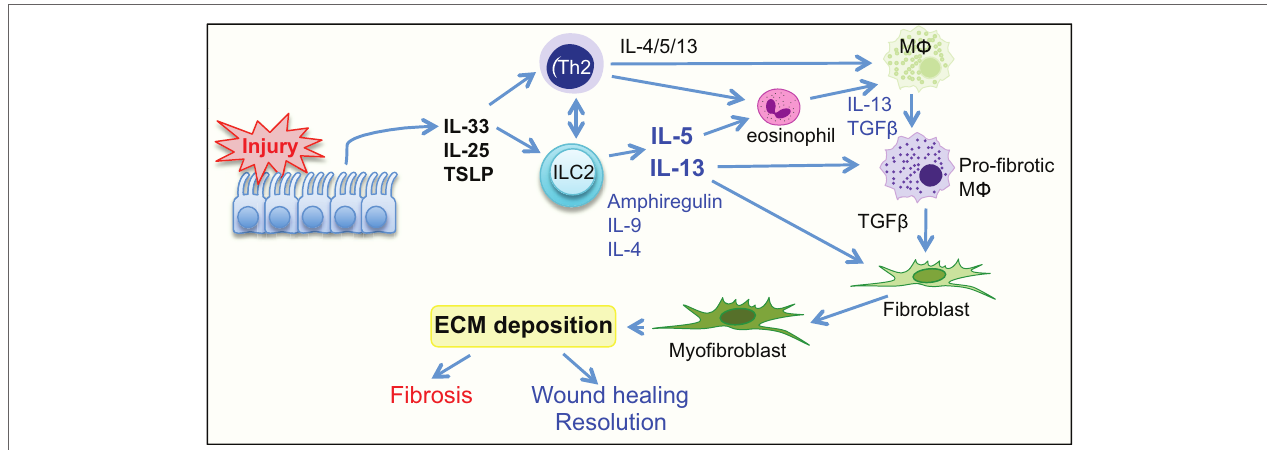
FiGURe 2 | Group 2 innate lymphoid cells have a central role in wound healing and fibrosis . Tissue injury initiates the release of the alarmin cytokines IL-25, IL-33, and TLSP from the epithelium. This activates ILC2 and Th2 cells to release the cytokines IL-4, IL-5, IL-13, also amphiregulin, and IL-9. The release of Th2 cytokines actively promotes activation of resident macrophages to a profibrotic phenotype, induces eosinophils to release the profibrotic cytokines IL-13, PDGF, and TGF β , and can also directly influence differentiation of fibroblasts to myofibroblasts. TSLP, thymic stromal lymphopoetin; TGF β , transforming growth factor β ; ILC2, group 2 innate lymphoid cell; M Φ ,